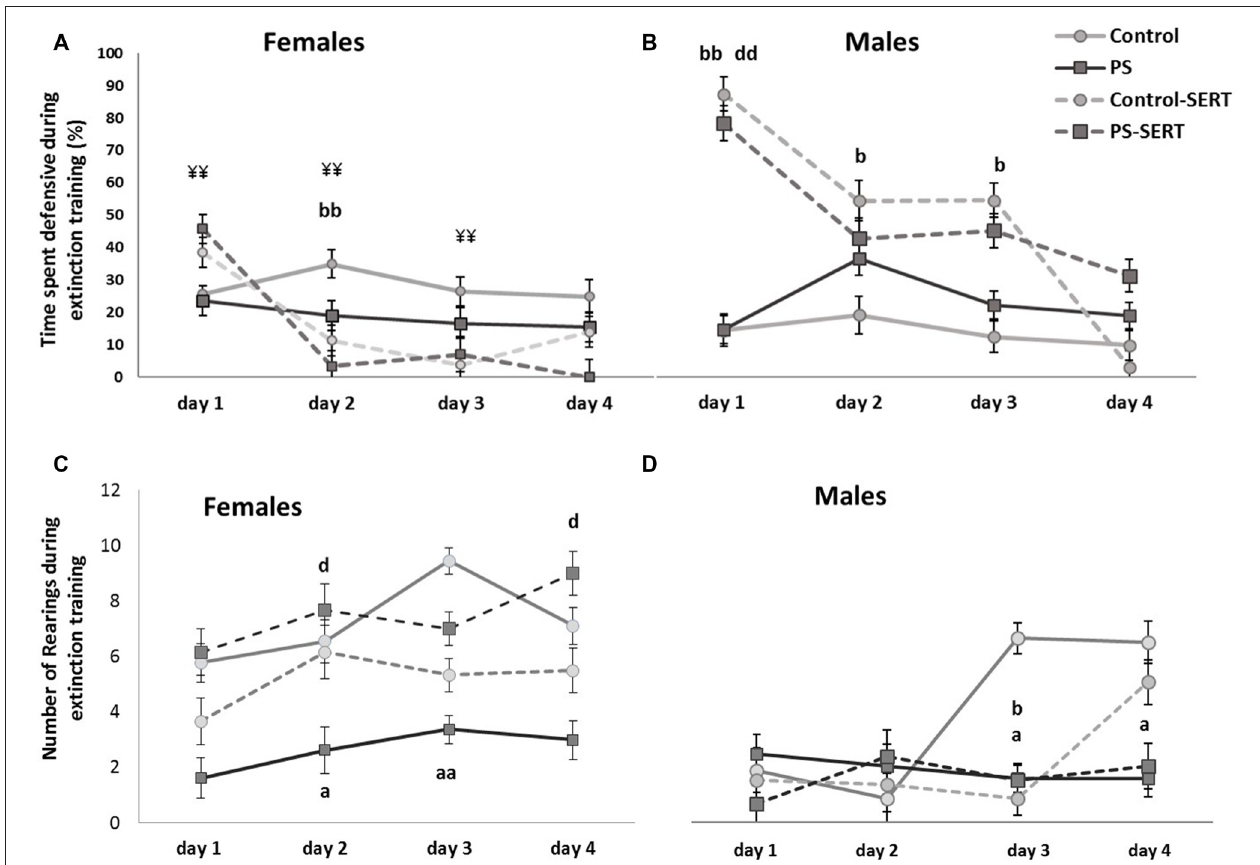
FIGURE 5 | Effects of prenatal stress and SERT treatment (5 mg/kg/day) in the time, the animals of both sexes, spent displaying defensive behavior (A,B) ; and in the number of rearings (C,D) , when they were re-exposed to the shuttle box, after the footshocks delivery, i.e., during extinction training ( n = 8–9 animals per group and sex). bb p < 0.01 and b p < 0.05, indicate the significant effect of SERT in control animals; d p < 0.05, and dd p < 0.01, indicate the significant effects of SERT in PS animals; (cid:85)(cid:85) p < 0.01, indicate the differences between sexes in the animals taking SERT (Mean values ±